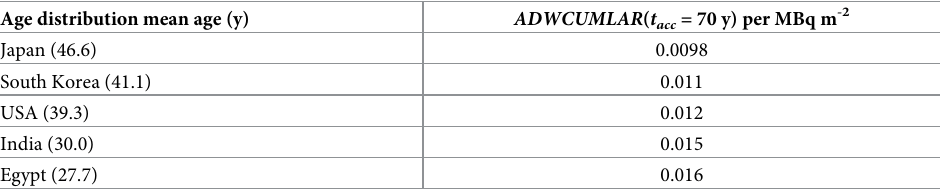
Table 7. Age-distribution-weighted cumulative lifetime attributable risk of cancer incidence (excluding non-fatal skin cancers) over 70 y, ADWCUMLAR ( t acc = 70 y), per unit total regional deposition activity of 137 Cs, A tot , reg (MBq m -2 ), for five types of age distributions taken from the United Nations